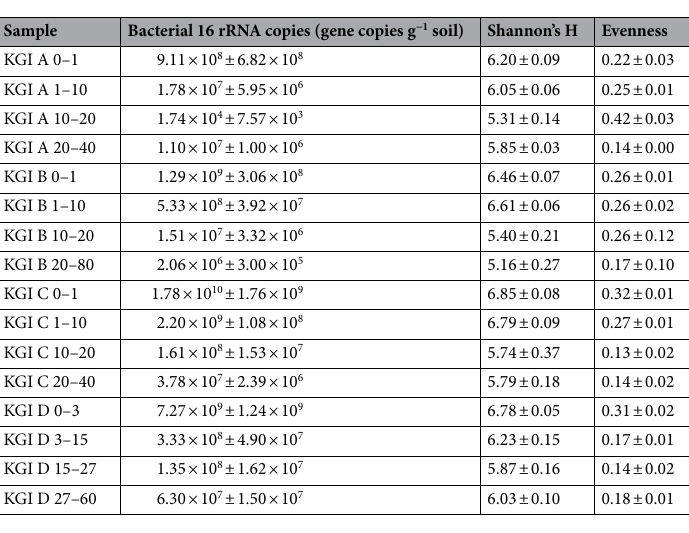
Table 2. Bacterial abundances and microbial diversity in four different soil profiles close to the Ecology Glacier, King George Island.